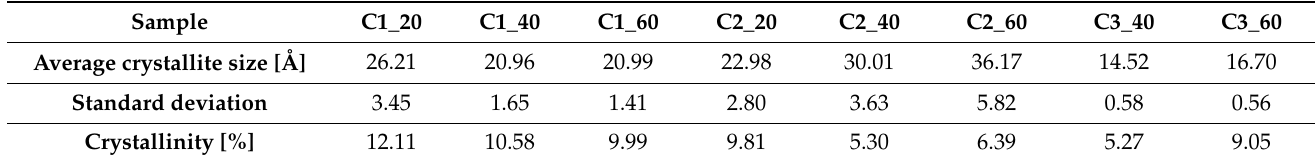
Table 2. The average crystallite size and he crystallinity of the MNPs